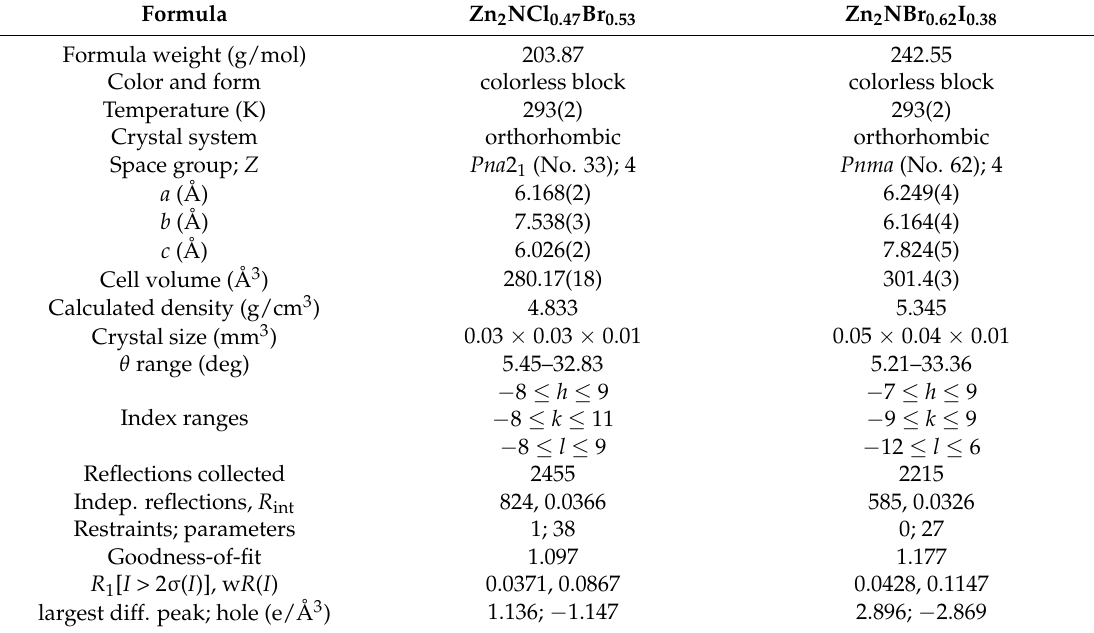
Table 1. Crystal data and details of the structural refinements of Zn 2 NCl 0.47 Br 0.53 and Zn 2 NBr 0.62 I 0.38 .